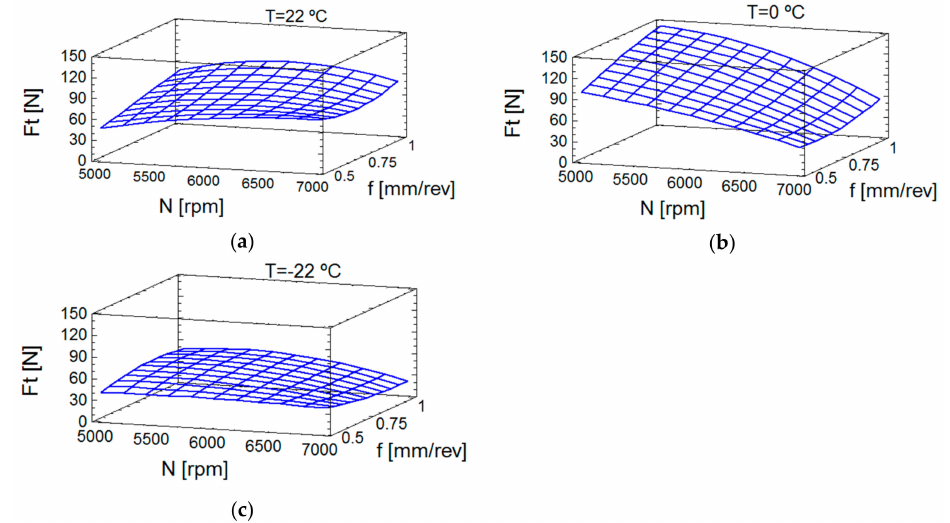
Figure 4. Estimation of response surface for thrust forces: ( a ) Temperature of 22 ◦ C; ( b ) Temperature of 0 ◦ C; ( c ) Temperature of − 22 ◦ C.